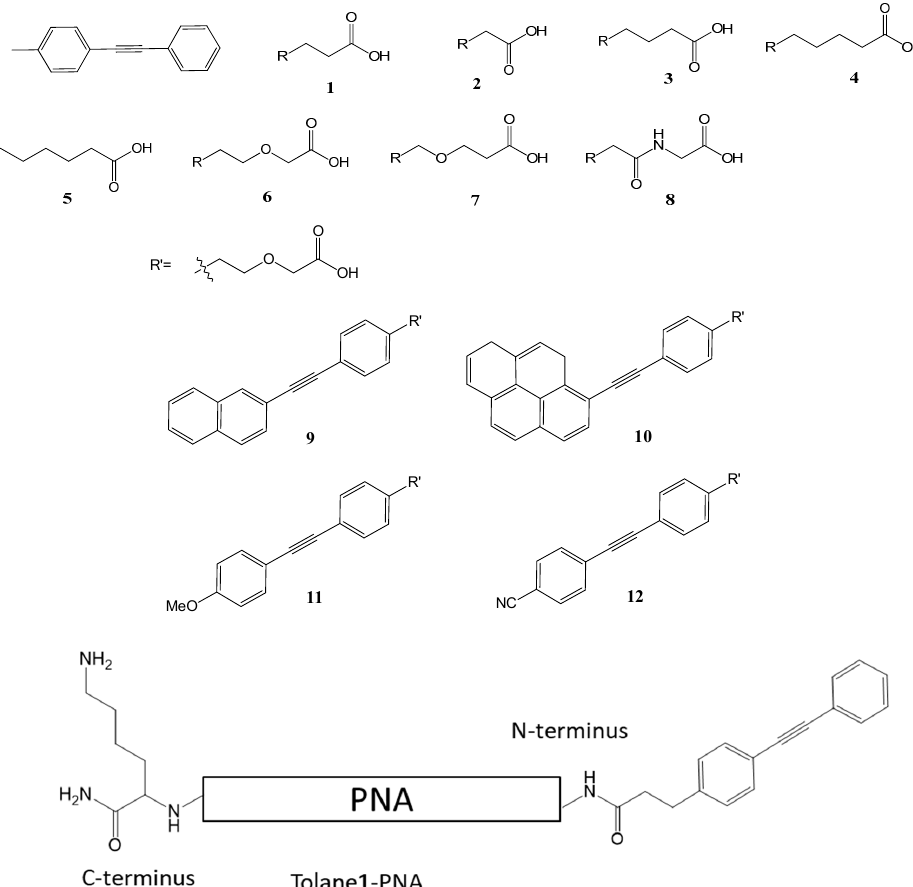
Figure 2. Chemical structure of the tolane derivatives. 1 – 5 ) tolanes containing di ff erent alkyl linker lengths, 6–8 ) tolanes containing either ether or amide linkages, 9 – 12 ) tolanes containing di ff erent pi-conjugation systems. Tolane 1 -PNA) Schematic diagram of tolane 1 modified PNA. A lysine residue was introduced to the C-terminus of the PNA molecule to increase water solubility. Tolane 1 was attached to the N-terminal amino group through an amide